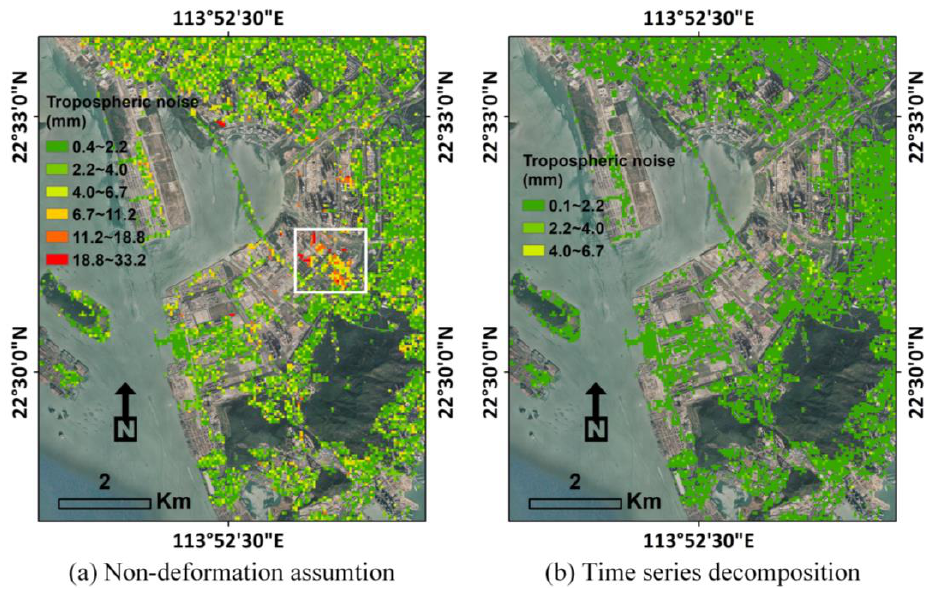
Figure 7. Time series RMS estimated in the Qianhai sub-area after correction using ERA5 and StaMPS spatiotemporal filtering. ( a ) Derived based on the none-deformation assumption; ( b ) derived with bias mitigated using the proposed time series decomposition method.